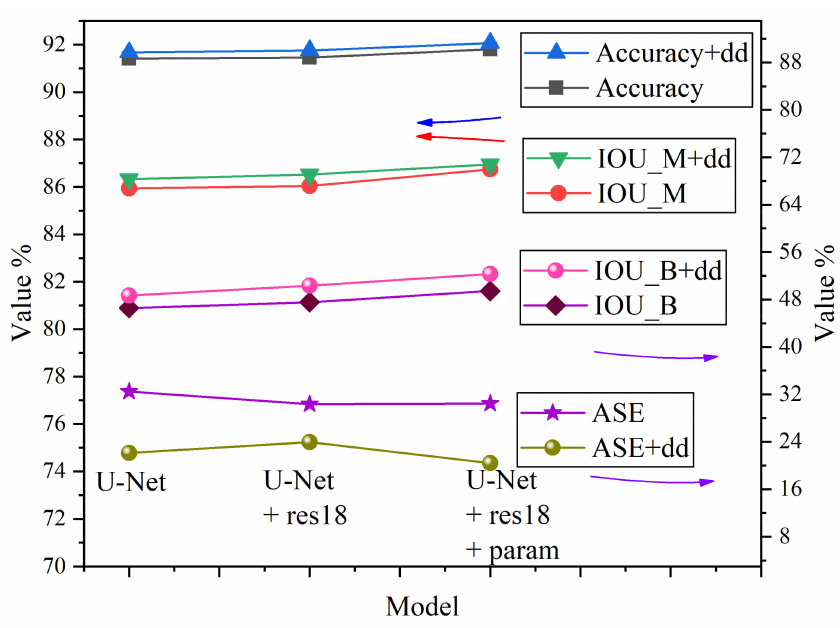
Figure 6. Comparison among different U-Net based models. The prediction results of U-Net and U-Net+dd are shown in Figure 7, where green boxes represent better predictions. U-Net+dd was more conducive to segmentation of adhesive ores. The U-Net+res18+param+dd model had another 3.46% higher IOU_B and a 1.75% lower ASE rate compared with that of U-Net+dd, while exhibiting the highest pixel accuracy rate and IOU_M; therefore, it was chosen as our final model. The pixel accuracy rate of our model was 92.07%, the IOU_M was 86.95%, the IOU_B was 52.36%, and the ASE rate was 20.38% on the testing dataset.